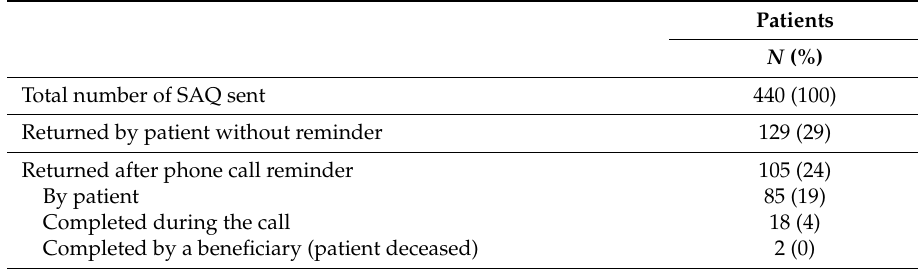
Table 3. Number of Self-Administered Questionnaires (SAQ) returned and reasons for